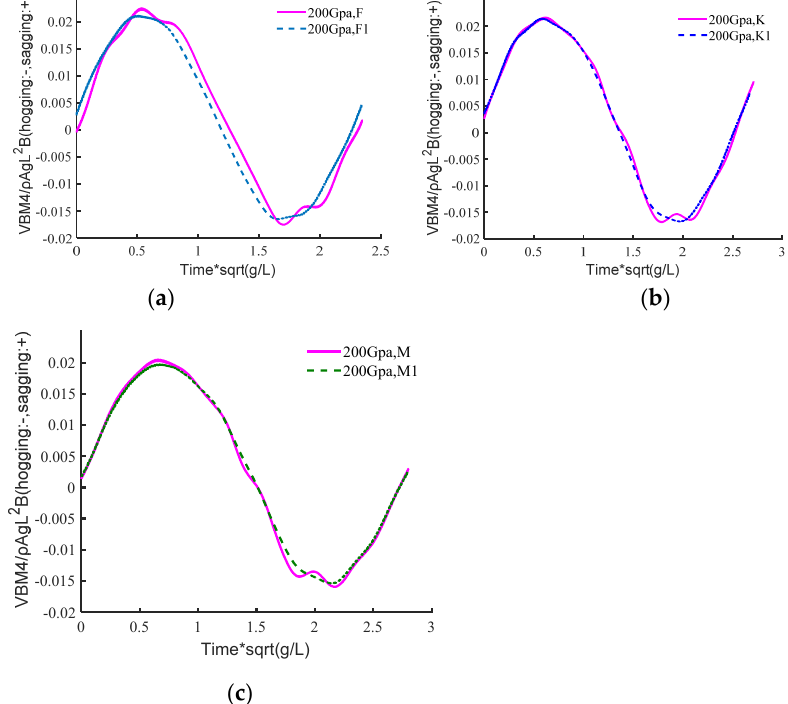
Figure 9. Non-dimensional vertical bending moment response of hull structure with E = 50 Gpa. ( a ) λ /L = 0.857; ( b ) λ /L = 1.070; ( c ) λ /L = 1.228.